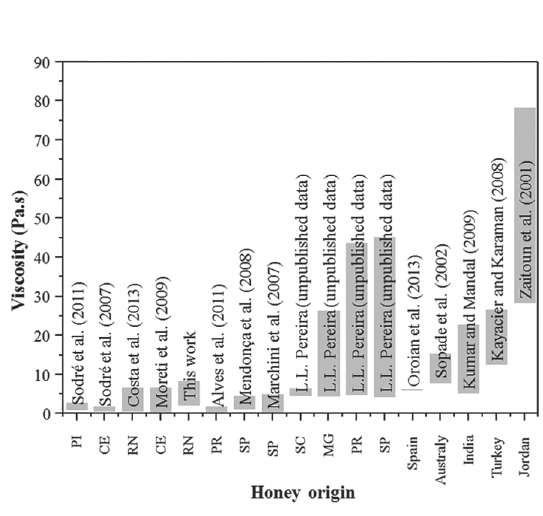
Figure 4 - Viscosity ranges (bars) to honeys from different origins reported by some authors. Viscosities measured at 293 K. All selected honeys in the figure were reported as